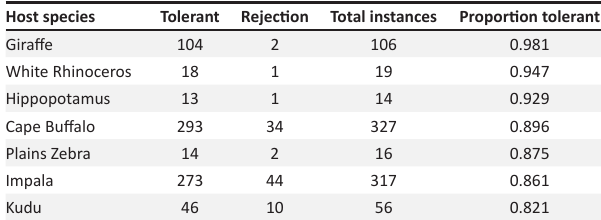
TABLE 2: Tolerance and rejection instances by host species in the Skukuza and Shingwedzi